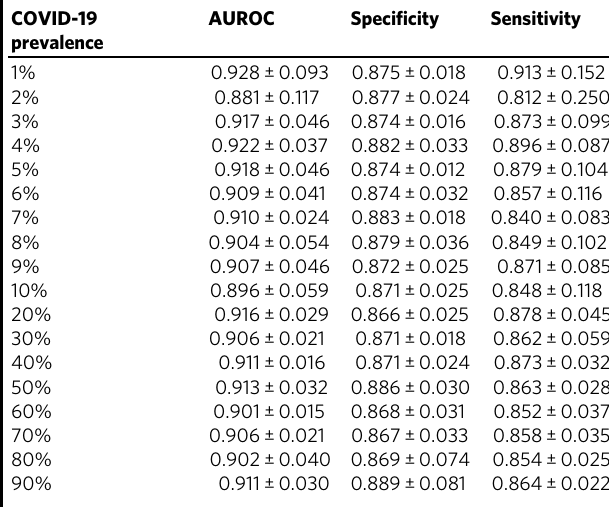
Table 3 COVID-19 endemic and pandemic simulations. AUROC, Speci fi city and Sensitivity, and the respective con fi dence intervals for different COVID-19 prevalence simulations under 95% con fi